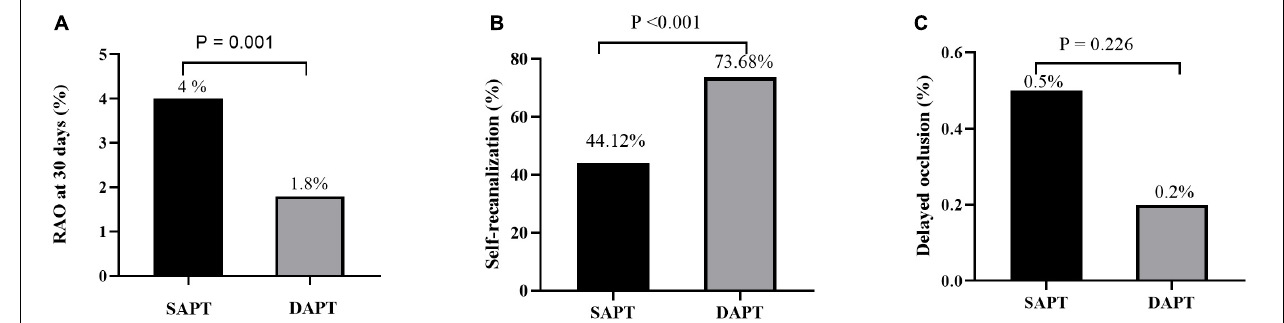
FIGURE 2 | RAO rate at 30 days after the TRCA (A) , self-recanalization (B) , and delayed RAO (C) between the SAPT group and DAPT group. RAO, radial artery occlusion; TRCA, transradial coronary angiography; SAPT, single-antiplatelet therapy; DAPT, dual-antiplatelet therapy.